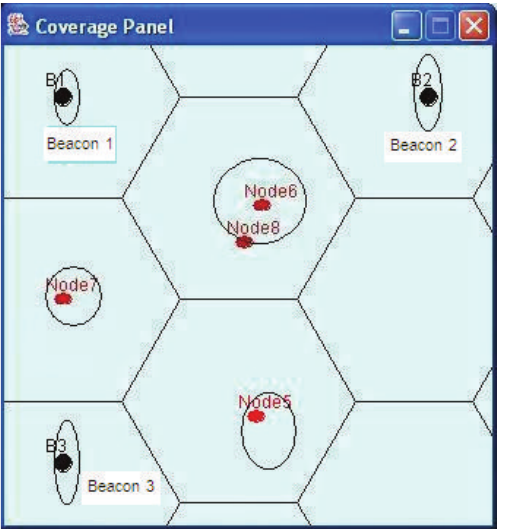
Figure 18: Intermediate location of mobile nodes.